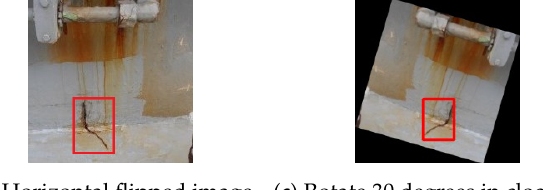
Figure 2. Image augmentation example: horizontal flip, rotation, and